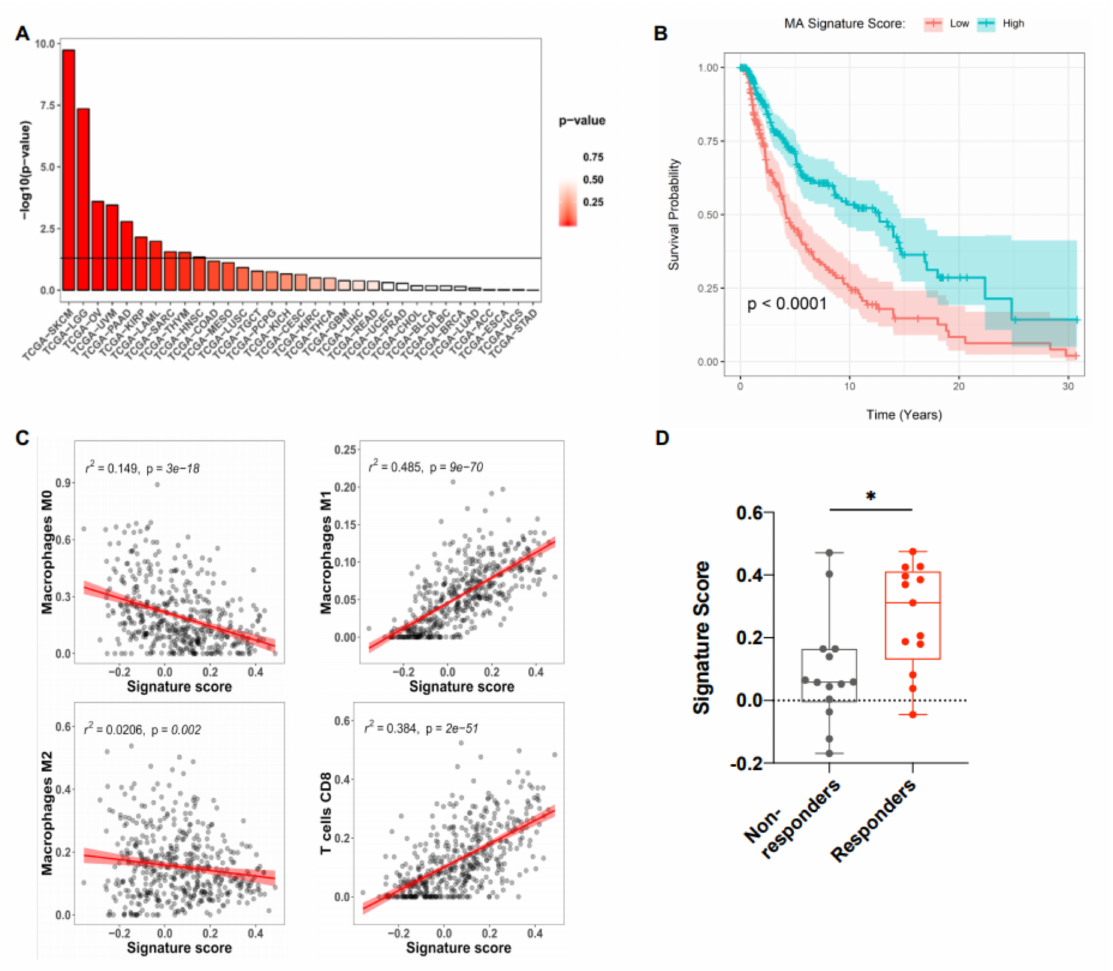
Figure 3. MA signature positively correlates with increased overall survival and the presence of M1 macrophages and CD8 + T cells in melanoma. ( A ) RNA-seq data from various tumor types were obtained from TCGA and the MA signature score was assessed with a non-parametric, rank-based method in R using the singscore package. The horizontal line indicates a p value of 0.05. ( B ) Kaplan–Meier survival curves of patients with high and low MA signature expression plotted as -log10 p values of log-rank tests of survival data for skin cutaneous melanoma (SKCM) with high vs. low MA signature gene expression (split by median) performed in R using the survminer package ( n = 118). ( C ) Pearson correlation of the MA signature score and the presence of immune cell subsets in SKCM patient data obtained from TCGA. The estimated abundance of various immune cells was determined by Cell-type Identification By Estimating Relative Subsets Of RNA Transcripts (CIBERSORT). Each dot represents an individual patient. ( D ) Signature score in melanoma patients receiving anti-PD-1 (Nivolumab, Pembrolizumab) treatment. Patients were stratified into responders (complete response and partial response, n = 13) and non-responders (progressive disease, n = 14). Each dot represents an individual patient and only patients sampled pre- and post-treatment were included in the analysis. Dataset was obtained from GSE91061. Box plot defines the maximum, third quartile, first quartile, and minimum values. p -values were determined by two-sided Welch’s t-test (* p < 0.0332; ** p < 0.0021; *** p < 0.0002; **** p <